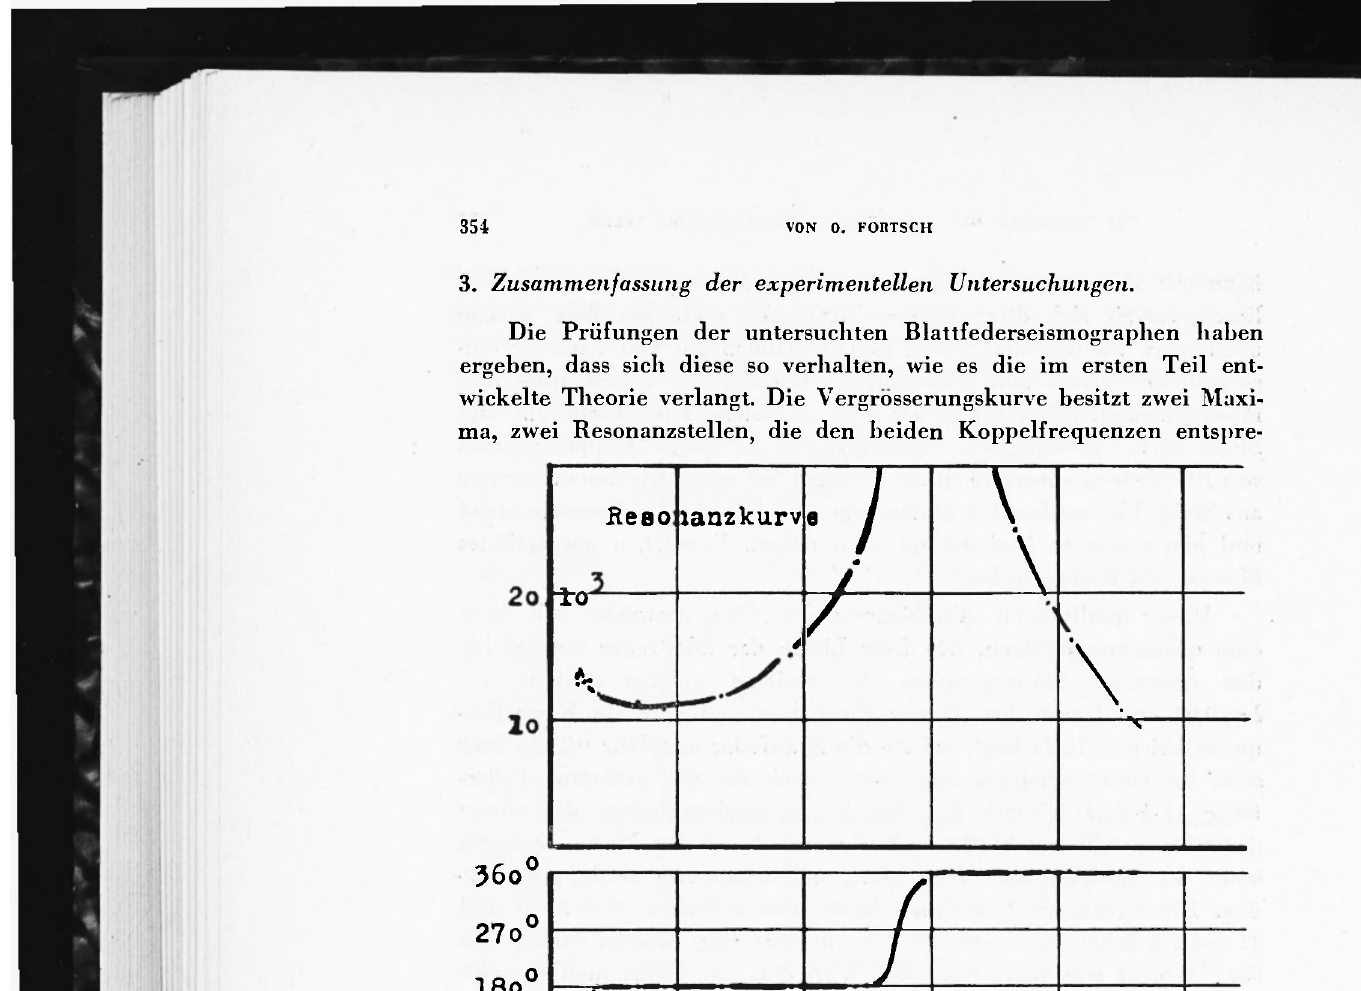
Fig. 9 - Resonanz- und Phasenkurve des Vertikalseismographen ZIO. Die Blattfe- dern waren zwischen Aluminiumbacken geklemmt. Die freie Liinge der Blattfeder betrug 0,02